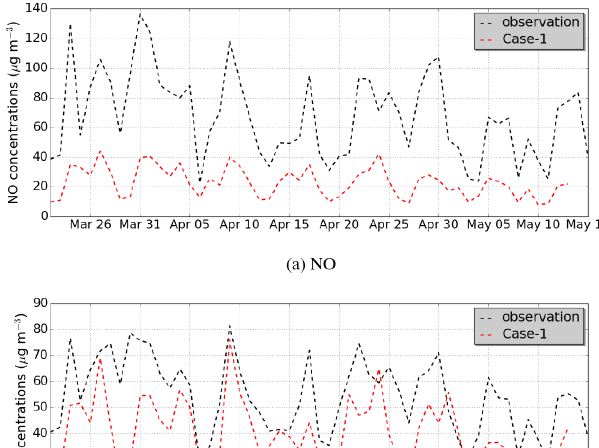
tained using MUNICH v2.0 are reduced compared to those obtained using MUNICH v1.0, but they are still high. The discrepancies can be explained by uncertainties in the traffic emission data, the vertical transfer at rooftops, and the life- time of NO (Kim et al., 2018; Lugon et al., 2020). The statistical indicators for the simulated PM 10 and PM 2 . 5 concentrations are also satisfactory. For PM 10 concen- trations, both the acceptance and strict criteria are met for the different indicators. For PM 2 . 5 concentrations, the accep- tance criteria are met by the different indicators, but the